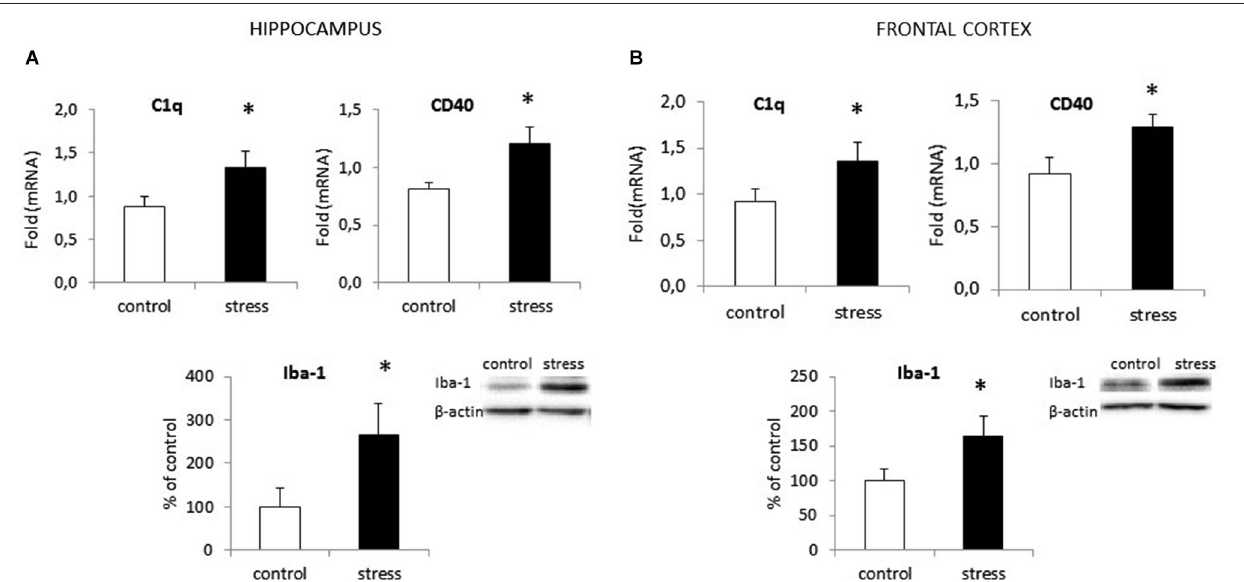
average fold ± SD, n = 6 in each group, * p < 0.05; one-way ANOVA. The results from western blot analyses are normalized with β -actin and presented as % of control ± SD, n = 6 in each group, * p < 0.05; one-way